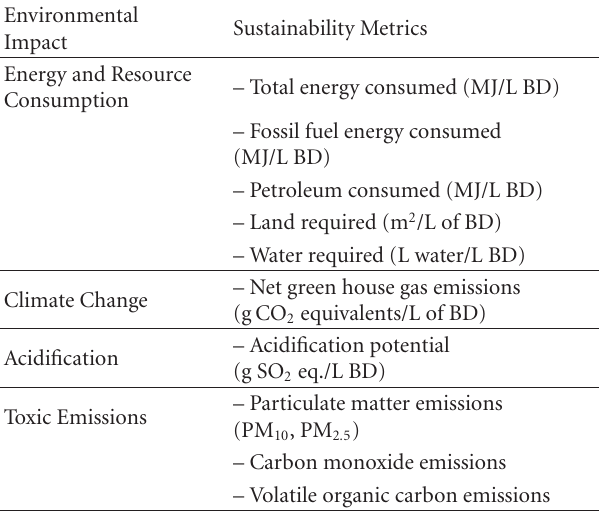
Table 1: Life cycle sustainability metrics for biodiesel.